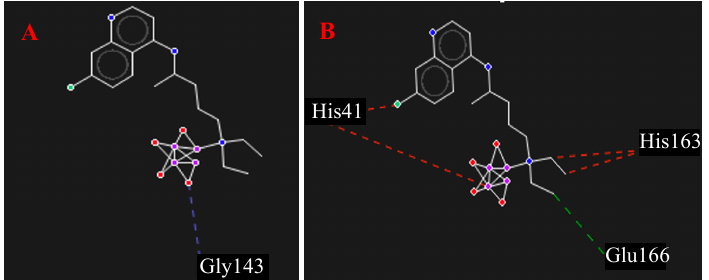
Figure 7. ( A ) H ‐ bond and ( B ) electrostatic interactions between the (ZnO) 4 ‐ Clq and the SARS ‐ CoV ‐ 2 ‐ M Pro . Green and red lines are the attraction and repulsion electrostatic interactions, respectively, and blue lines depicts the H ‐ bond interactions.